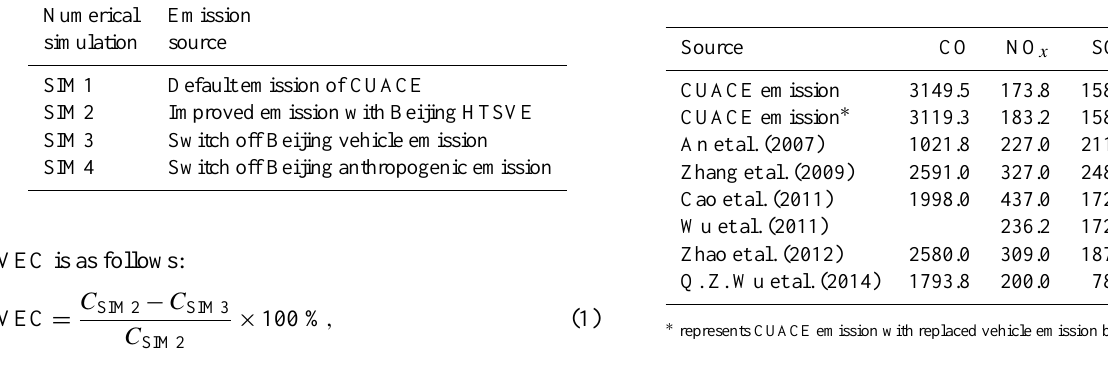
Table 3. The rate of major species from vehicle emission in total emission (unit: